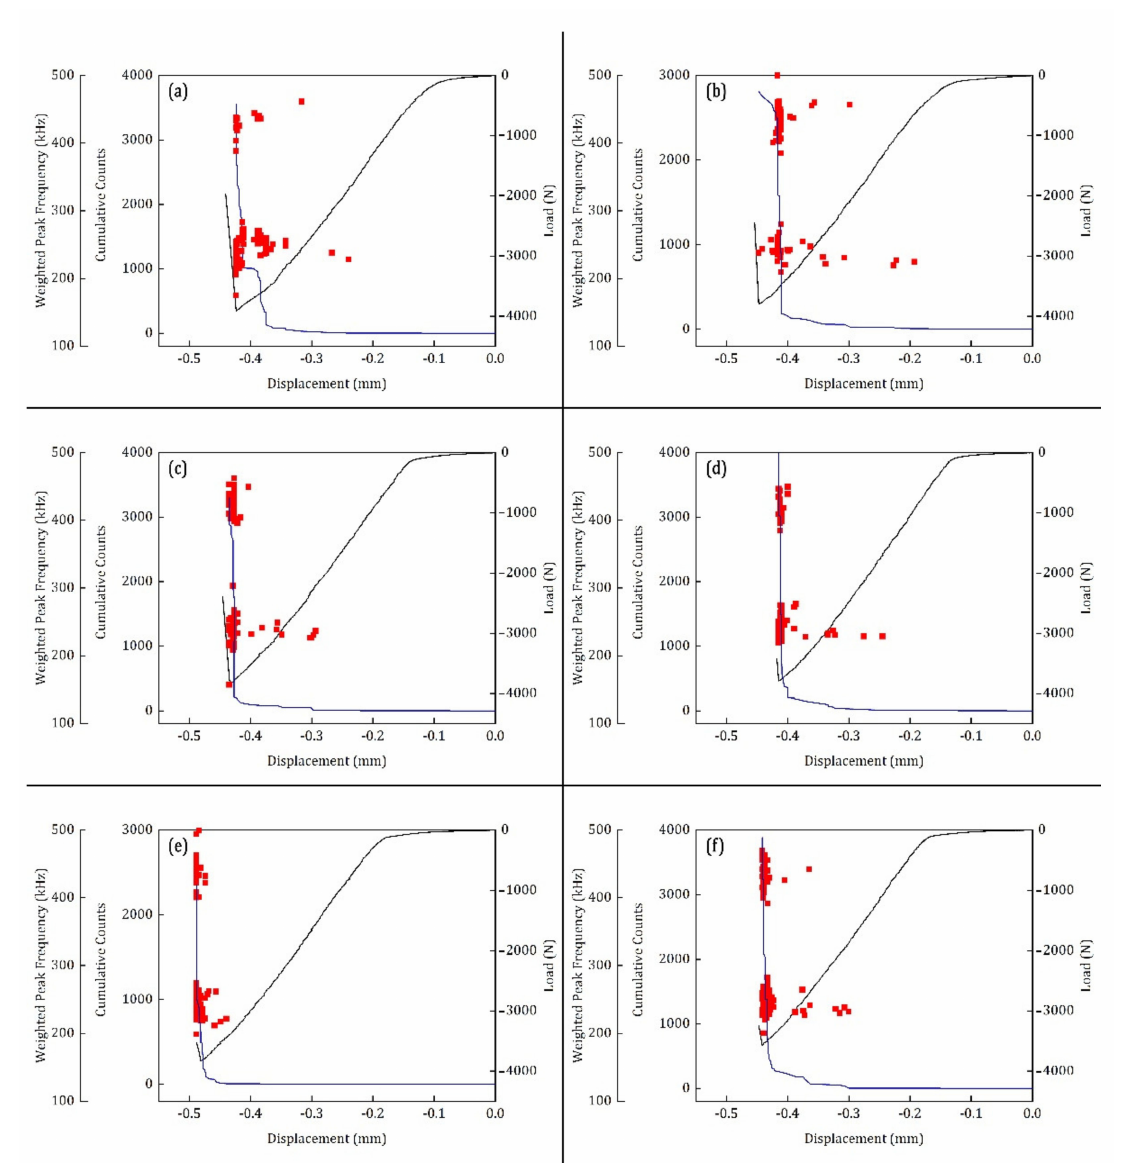
Figure 7. AE descriptors cumulative counts (blue lines) and W.P-Freq (red markers) plotted over the load–displacement curves of the SBS test performed at 100 ◦ C for the CFRP specimens ( a ) SBS_100–1, ( b ) SBS_100–2, ( c ) SBS_100–3, ( d ) SBS_100–4, ( e ) SBS_100–5 and ( f )